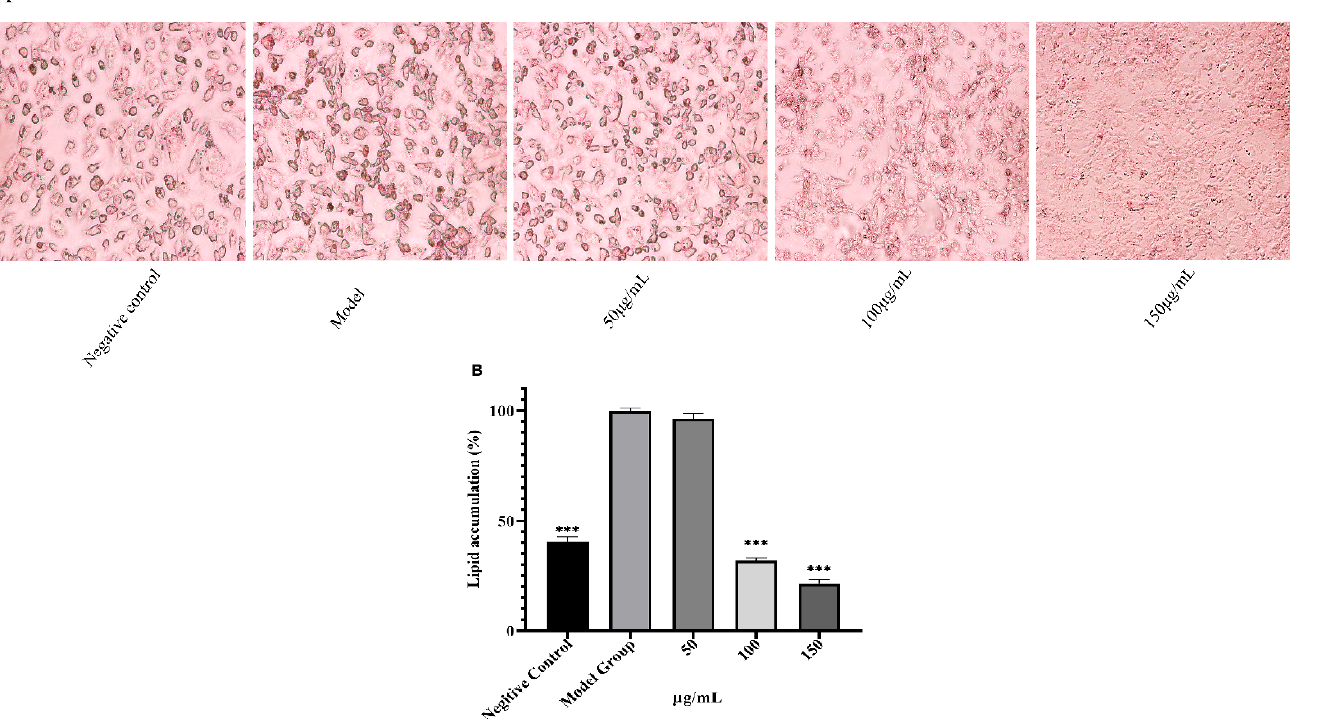
Figure 5. Cell lipid droplets stained with Oil red O were visualized under a microscope ( A ). Percentage (%) of accumulated lipid droplets in 3T3-L1 cells stained with Oil red O was observed on the 8th day of differentiation compared with the model group ( B ). The control cells were not exposed to any compound. The model cells were not treated with the extract; the values are means ± standard deviations from at least three independent experiments, n ≥ 12; the statistical significance was calculated versus the control cells *** p ≤ 0.001 vs. model group.